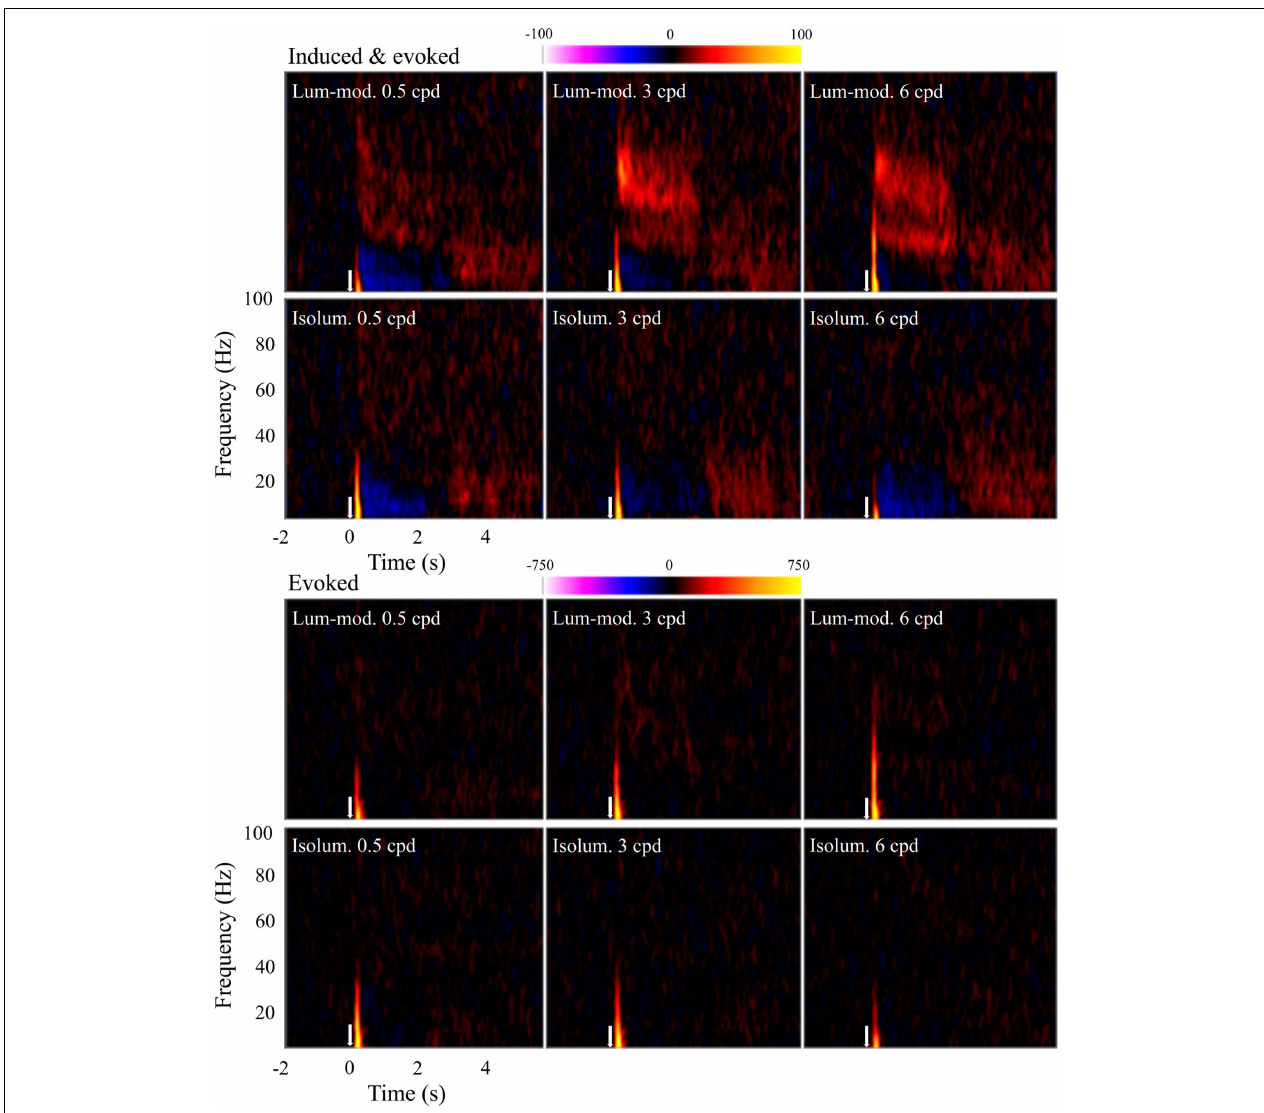
represent energy changes from baseline. Blue/purple colors depict energy decreases and orange/yellow colors depict energy increases. Stimulus onset was at time 0s (white arrow) and continued until